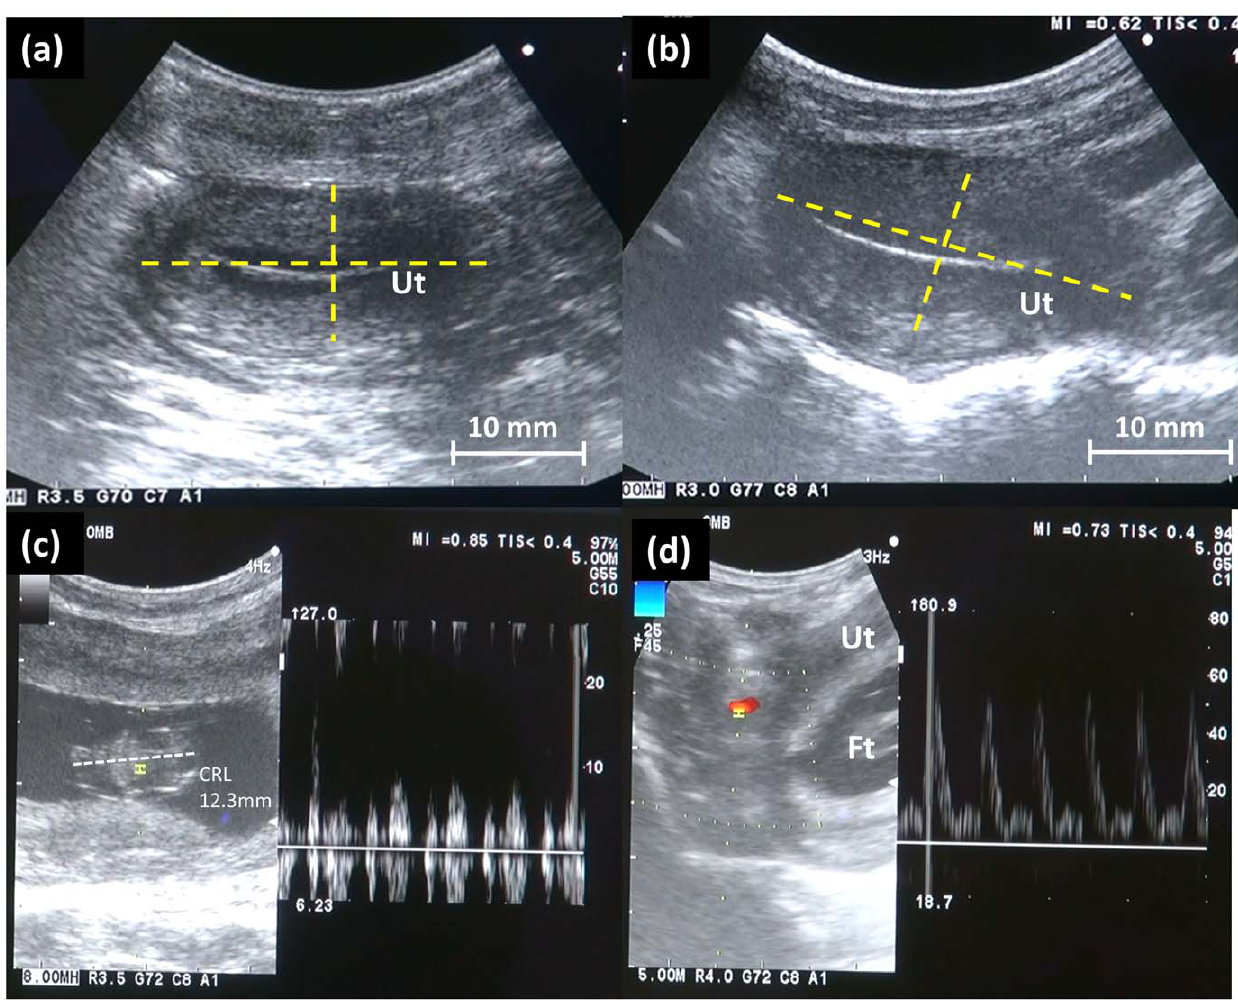
Figure 5. Postoperative evaluation of the uterus. (a) Transabdominal ultrasonography at the time of surgery showed the size of the uterine corpus was 25.2 6 13.1 mm (long axis 6 anteroposterior diameter) (b) The size of uterine corpus at 2 months after surgery was 25.0 6 13.8 mm, showing no major change in the size of the uterus. Ut: uterus. (c) At 37 days after mating, transabdominal ultrasonography revealed a viable fetus with crown-rump length 12.3mm and regular fetal heart beat. (d) The right uterine artery flow using Doppler ultrasonography was satisfactory and no collateral vessels toward the uterus were shown. Ut: uterus, Ft: fetus.